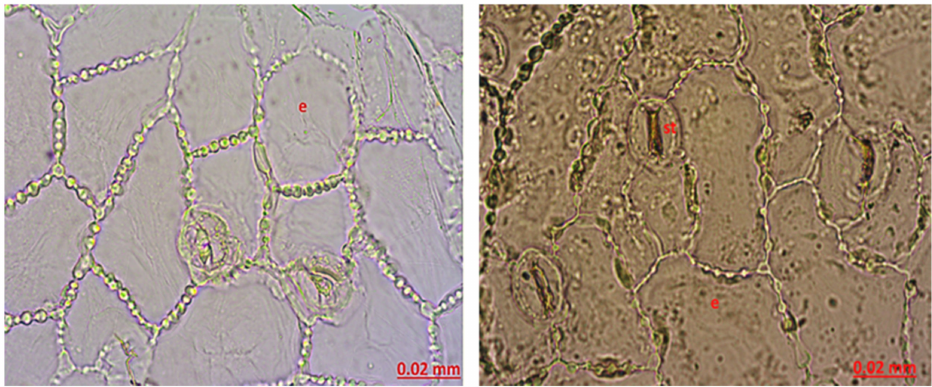
Figure 5. The leaf upper superficial anatomy of Hypericum scabrum ; e: epidermis, st: stomata. Stamen Anatomy: When the stamen structure was examined, a large amount of druse was found in the anther structure. Pollens were observed (Figure 6).